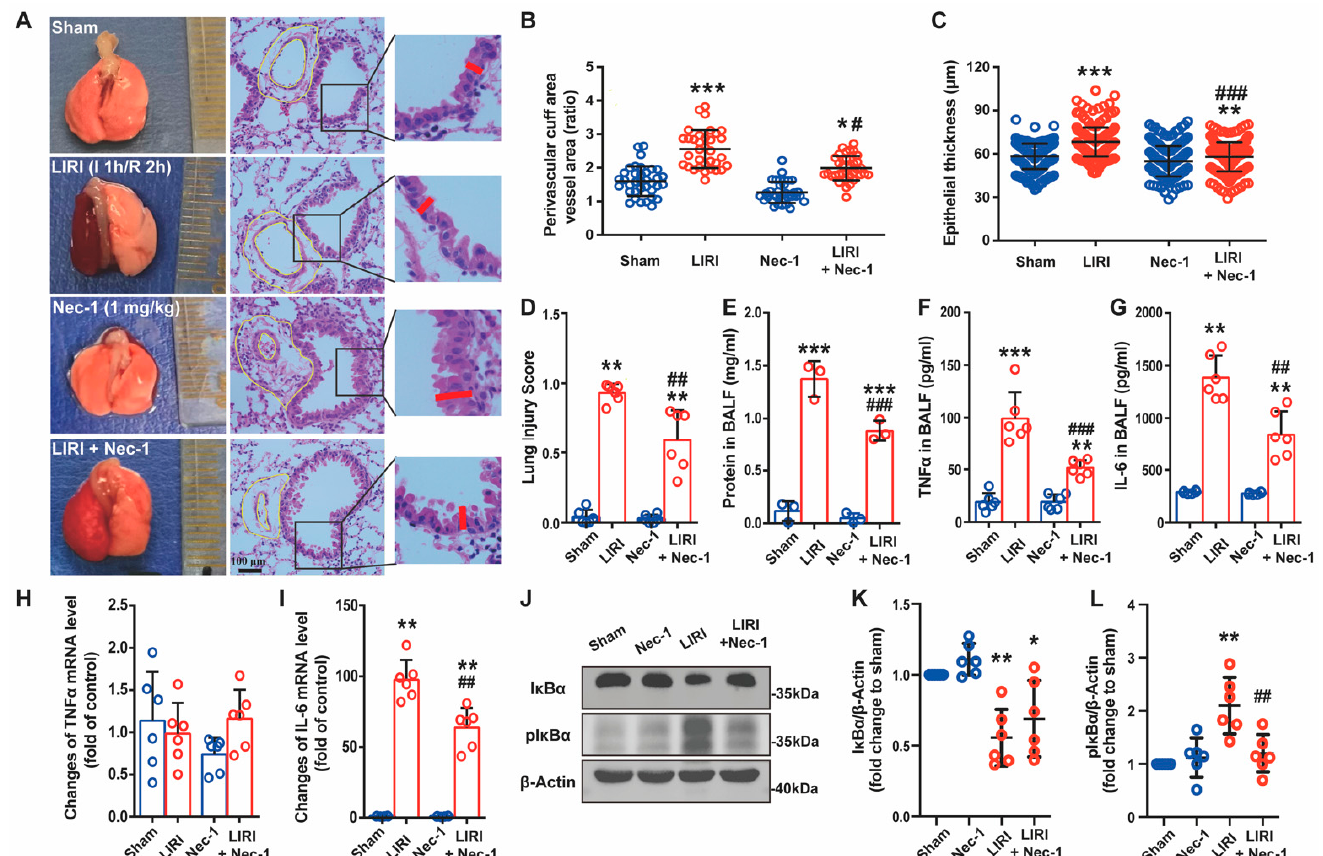
Figure 1. Necrostatin-1 alleviated lung injury and inflammatory response caused by ischemia reperfusion (IR) in mice. The lung ischemia-reperfusion injury (LIRI) was induced by clamping the left pulmonary hilum of the mouse for 1 h using a microvascular clip and then removing the clip for reperfusion for 2 h. Nec-1 (1 mg/kg) was administered intraperitoneal injection 1 h before ischemia. ( A ) Changes in the gross appearance of mouse lungs and the representative HE staining of the lungs. The area between the two yellow cycle was determined as the perivascular cuff area, and the red line indicated the thickness of the epithelium. ( B ) The ratio of perivascular cuff area to vessel area. ( C ) The thickness of the epithelial barrier. ( D ) Lung injury score. ( E ) Total protein exudation in the bronchoalveolar lavage fluid (BALF). ( F , G ) The concentration of TNF α and IL-6 in the BALF detected using ELISA. ( H , I ) The mRNA level of TNF α and IL-6 determined by real-time PCR. ( J ) The level of I κ B and phosphor-I κ B in lung tissue homogenates detected by Western blotting. ( K , L ) Quantification of proteins from Western blots in panel J. n = 6 animals per group. * p < 0.05, ** p < 0.01, *** p < 0.001, compared with Sham; # p < 0.05, ## p < 0.01, ### p < 0.001, compared with LIRI; one-way ANOVA.